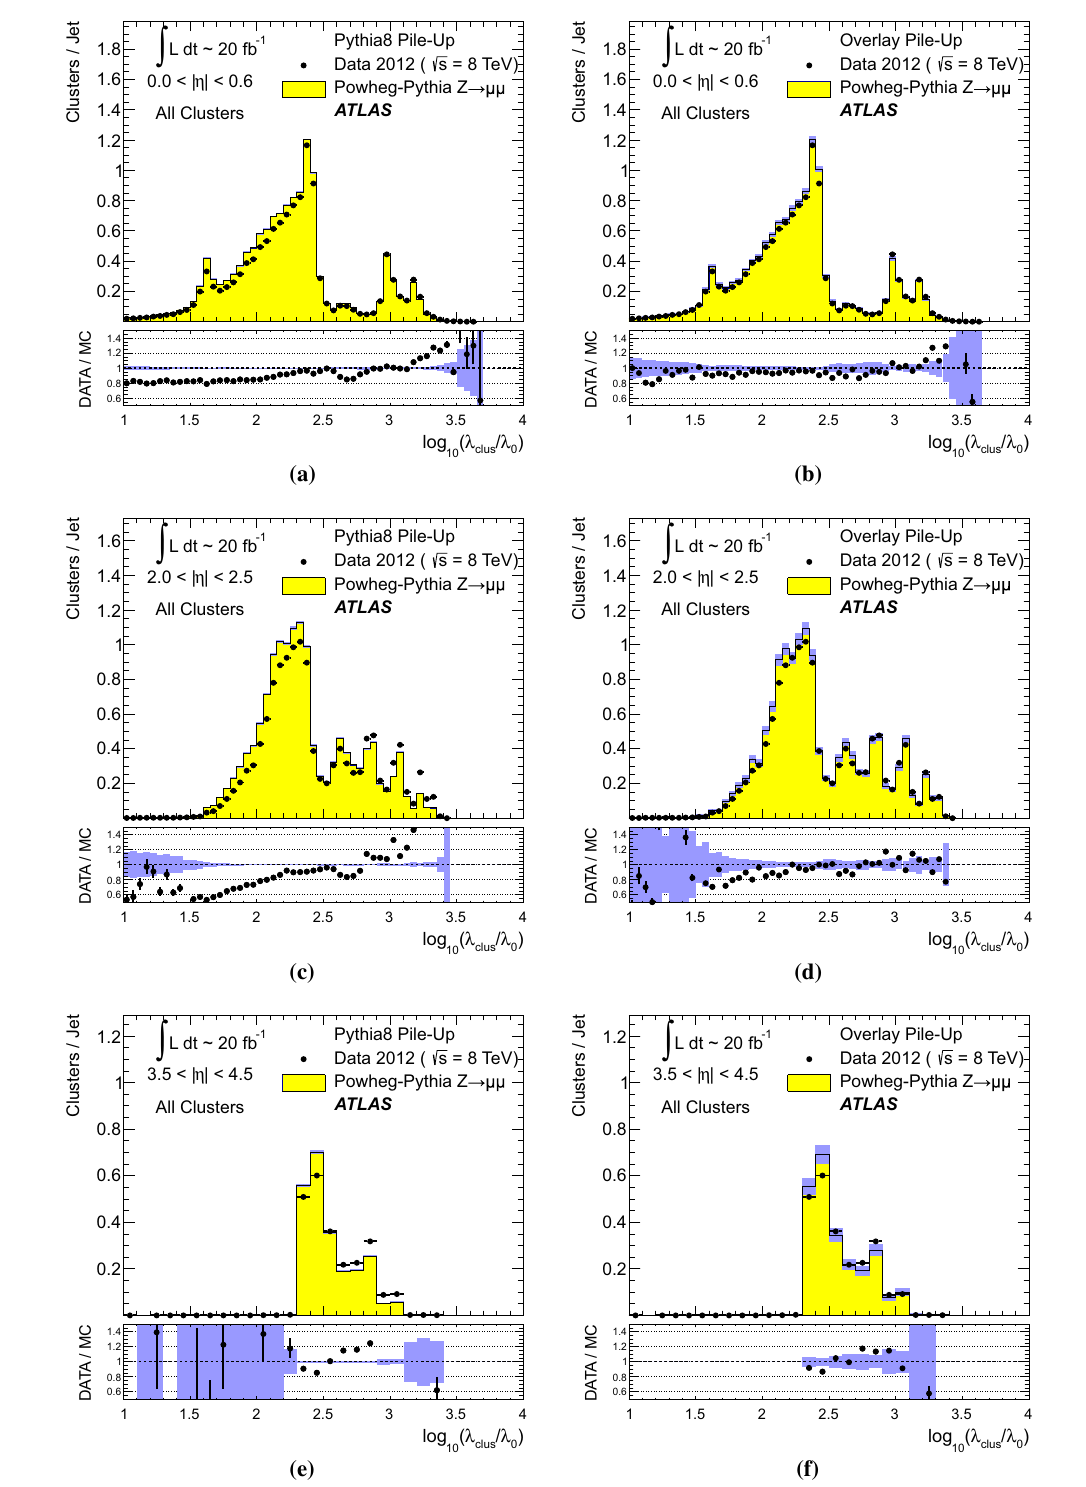
Fig. 34 The distribution of the depth location, measured in terms of log 10 (λ clus /λ 0 ) with λ 0 = 1 mm, of all topo-clusters in jets recon- structed with the anti- k t algorithm with R = 0 . 4 and with 30GeV < < 40GeV in Z → μμ events in 2012 data and MC simu- p LCW + JES T , jet lations with ( a , c , e ) fully simulated pile-up and with ( b , d , f ) overlaid pile-up from data. Distributions are shown for jets in the ( a , b ) central